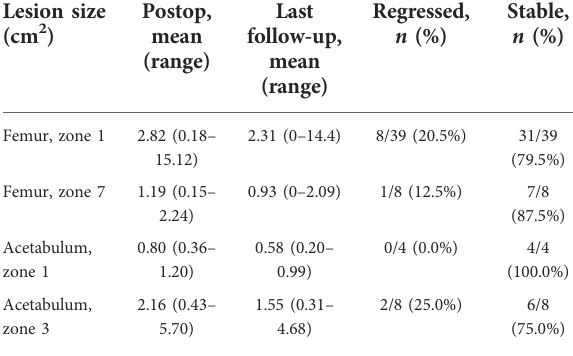
TABLE 3 Comparison of lesion sizes between immediate postoperation and last follow-up and the proportion of regressed lesions and stable lesions,